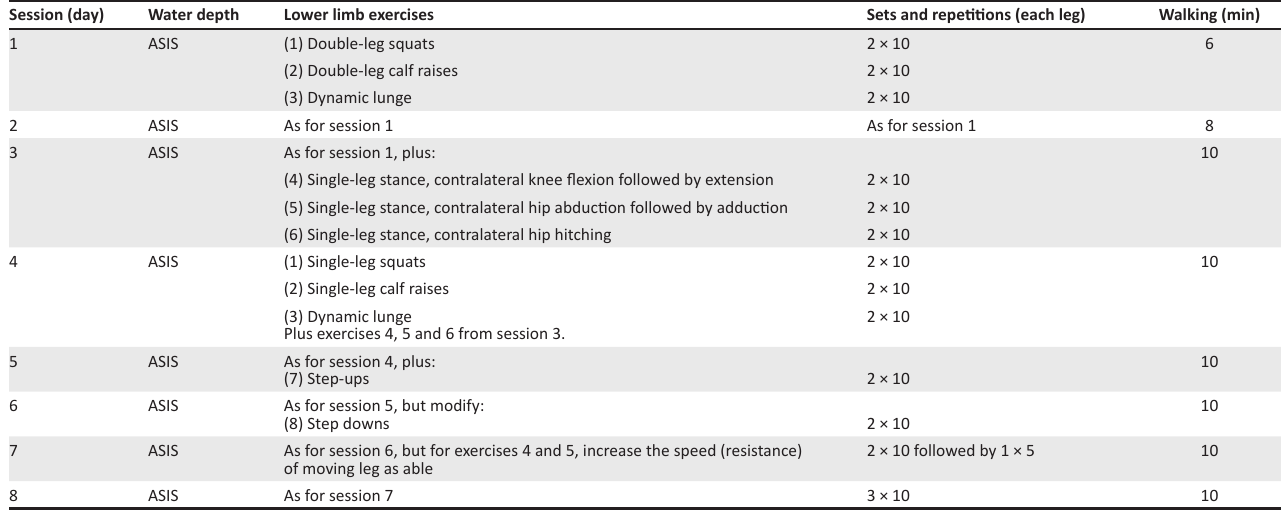
TABLE 1: Hydrotherapy exercise programme. Session (day) Water depth Lower limb exercises Sets and repetitions (each leg) Walking